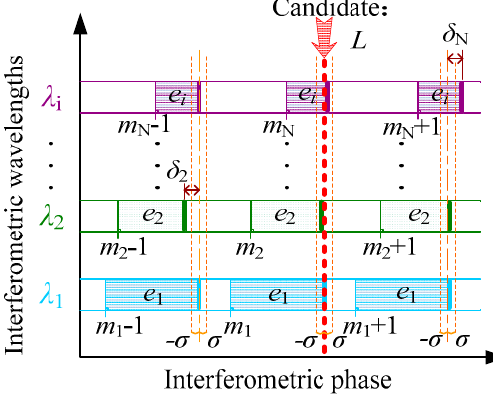
Figure 1. The diagram of the excess fraction method.